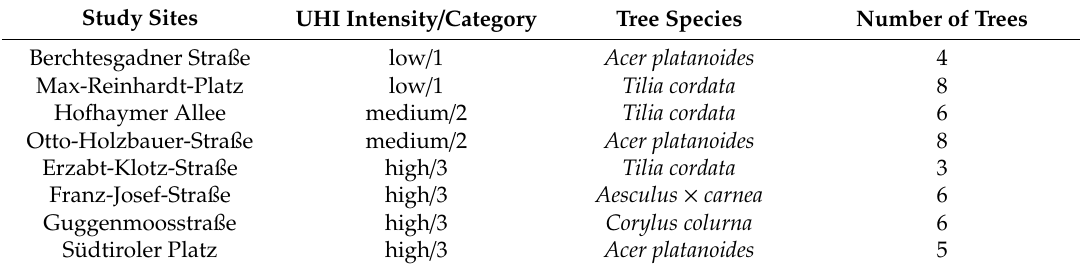
Table 1. Overview of the study sites with urban heat island (UHI) intensity / category, tree species, and number of